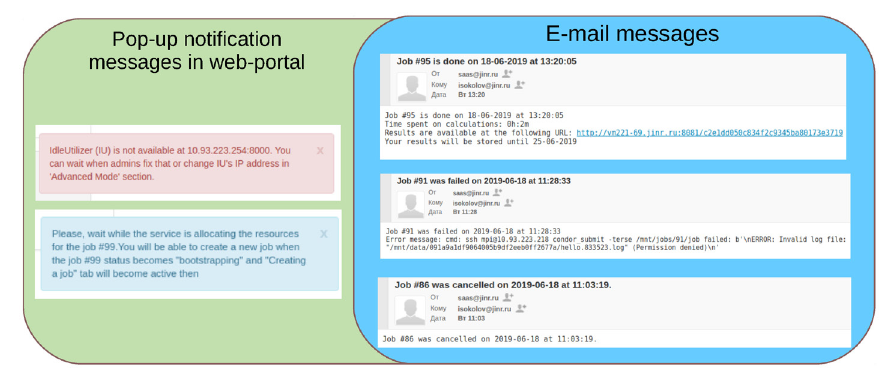
Figure 2. The notification system on